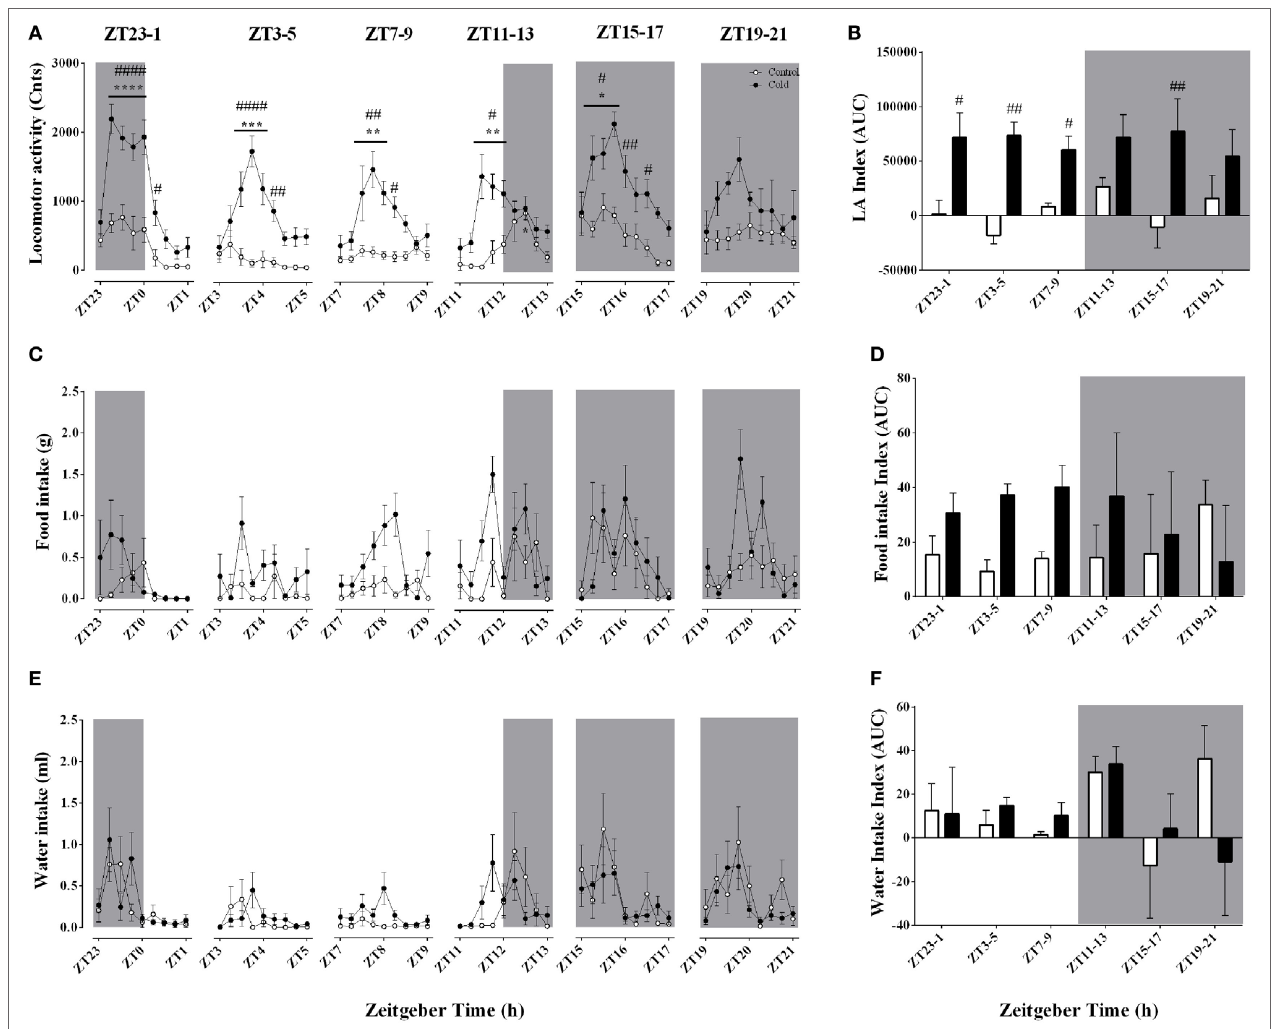
FigUre 4 | Effect of time­of­day on locomotor activity (a,B) , food intake (c,D) , and water intake (e,F) changes induced by environmental cooling. Results are presented as averages of 15 min bins during 2 h of environmental cooling (a,c,e) and area under the curve (AUC) (B,D,F) calculated as the net change from the basal levels before cold exposure. Light phase began at ZT and dark phase (shaded areas) began on ZT12. Results are presented as mean ± SEM. * indicates differences between the first and the other time­points within the control or the cold­exposed group, p < 0.05. # indicates differences between control and cold conditions, p < 0.05 . n =